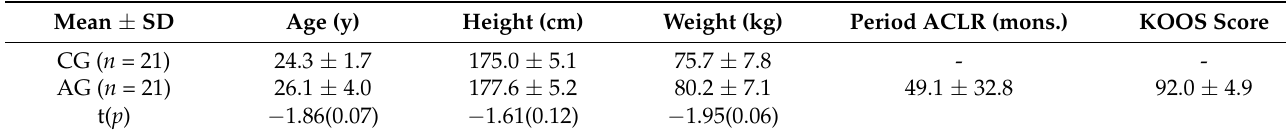
Table 1. Summary information of the